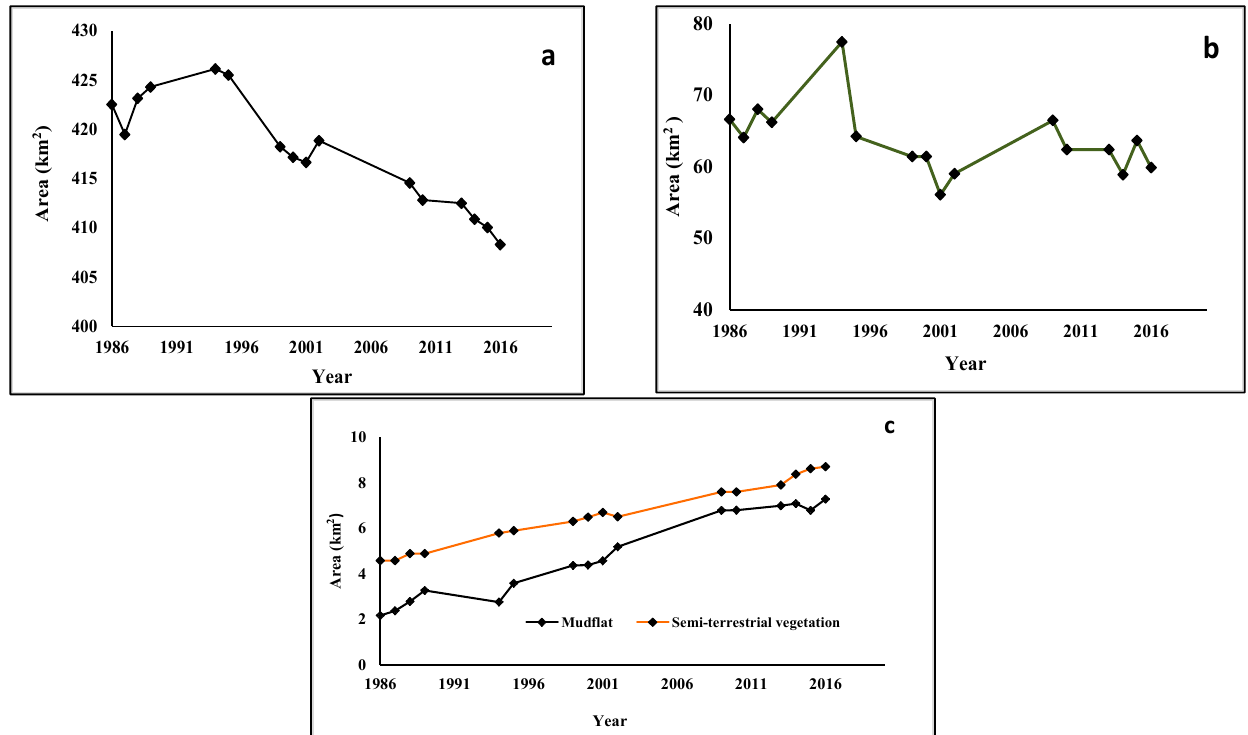
Figure 6. Change in area distribution of ( a ) surface water area ( b ) macrophytes ( c ) semi-terrestrial vegetation and mudflat in different periods in and around Lake Ziway.